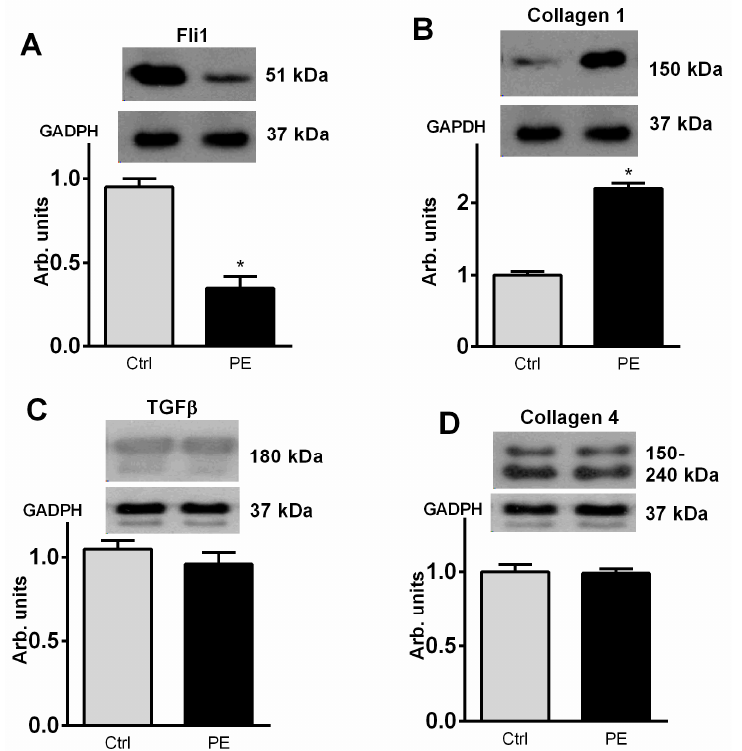
Figure 3. Levels of Fli1 ( A ), collagen-1 ( B ), TGFß ( C ) and collagen 4 ( D ) (Western blot) in the umbilical arteries from subjects with uncomplicated pregnancy (Ctrl) and from patients with preeclampsia (PE). Top panels. Western blotting representative bands; bottom panels, GAPDH for statistical analysis. Each bar represents individual samples pooled and averaged to give means and SEM of 5 measurements. By one-way ANOVA followed by Bonferroni test: * p < 0.01 vs. Ctrl.